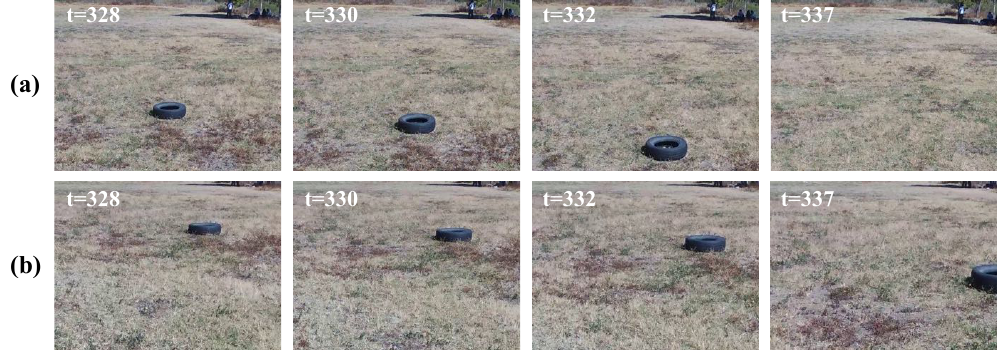
Figure 21. Failure cases in the evolved GWR detector on dataset D-4: ( a ) sample image frames in the exploration phase, and ( b ) false novelty indications in the inspection phase. In the exploration phase, the UAV explores environment O-3. Then, it should detect the person as the novelty in